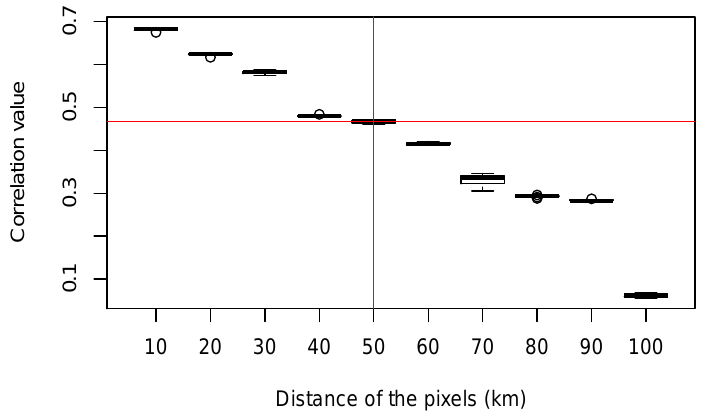
Figure 3. Distribution of correlation values between production and satellite data according to the distance of the